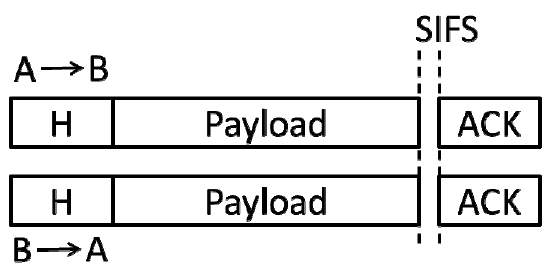
Figure 3. A and B send frames for each other simultaneously (FD_2 mode).